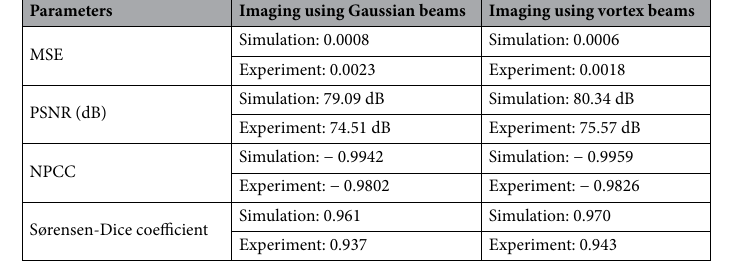
Table 1. Image enhancement using vortex beams and deep